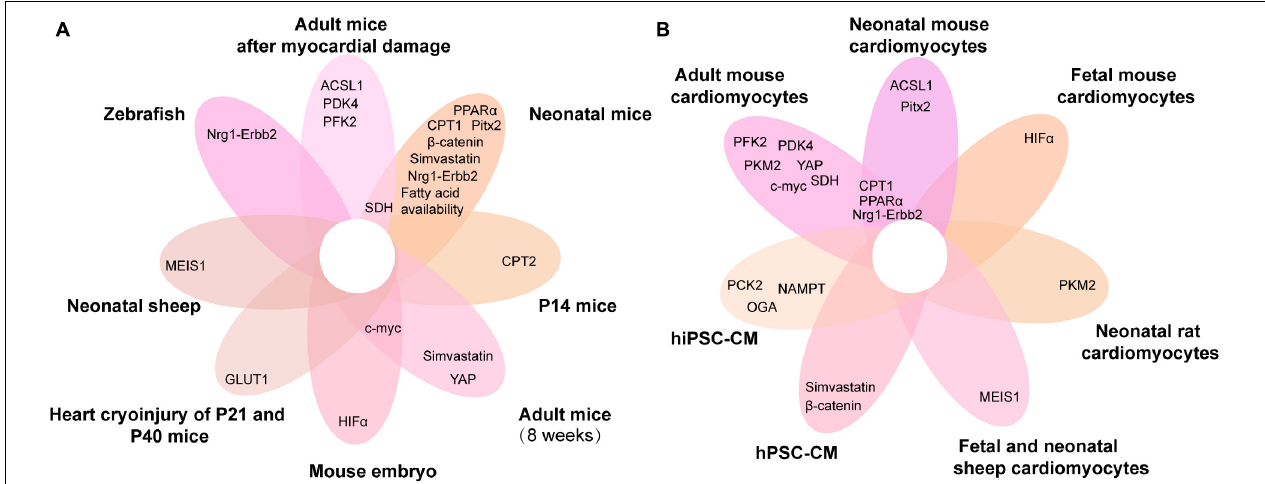
FIGURE 4 | Venn diagram of metabolic genes associated with cardiomyocyte proliferation overlapping in different animals and cardiomyocytes. (A,B) The metabolic genes associated with cardiomyocyte proliferation in different animals (A) and cardiomyocytes (B) . ACSL1, acyl-CoA synthetase long-chain family member 1; PFK, phosphofructokinase 2; PPAR α , peroxisome proliferator-activated receptor; HIF- α , hypoxia-inducible factor α ; PDK4, pyruvate dehydrogenase kinase 4; MEIS1, myeloid ecotropic viral integration site 1; PCK2, phosphoenolpyruvate carboxykinase 2; CPT, carnitine palmitoyltransferase; NAMPT, nicotinamide phosphoribosyltransferase; YAP, yes-associated protein; Nrg1, neuregulin 1; SDH, succinate dehydrogenase; GLUT1, glucose transporter 1; Pitx2, paired-like homeodomain 2; hiPSC-CM, human-induced pluripotent stem cell cardiomyocytes; hPSC-CM, human pluripotent stem cell-derived cardiomyocytes; P14, postnatal day 14; P21, postnatal day 21; P40, postnatal day